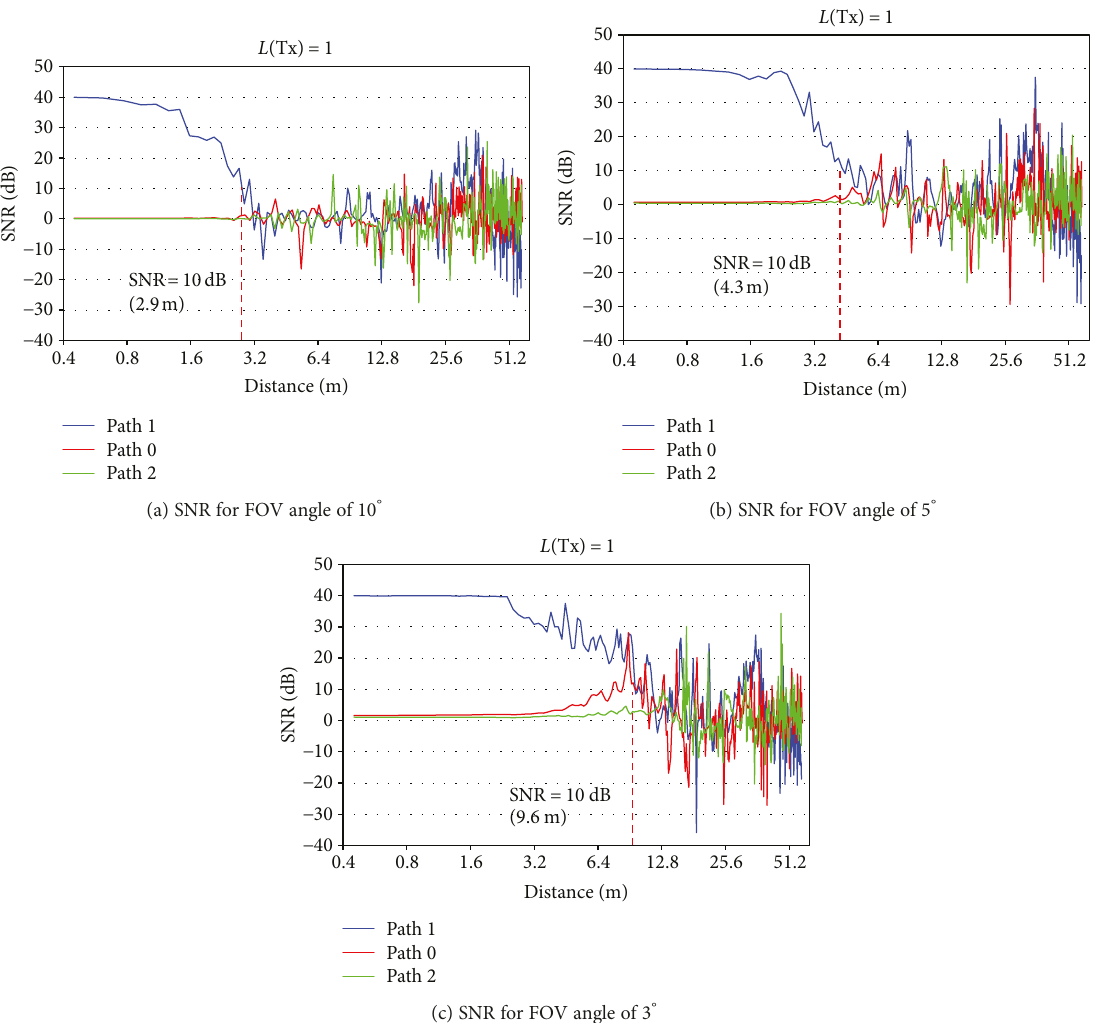
Figure 10: SNRs calculated for the corridor when the element antennas of OAM modes have FOV angles of 10 ° , 5 ° , and 3 ° . The OAM mode number of the transmitting antenna L Tx is zero.